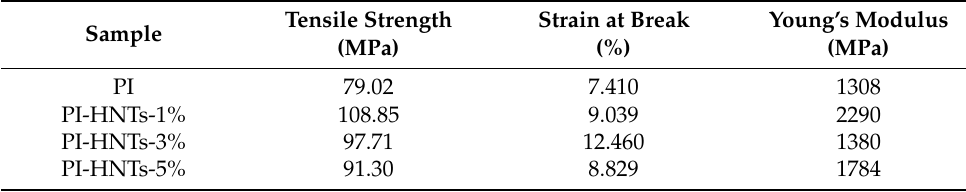
Table 4. Values of tensile strength, strain at break, and Young’s modulus for all